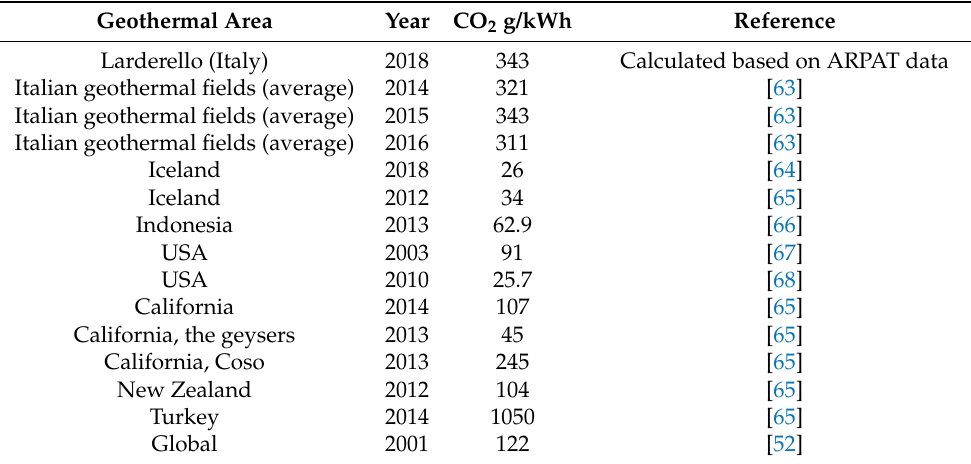
Table 5. CO 2 emission factors from GPPs around the world.